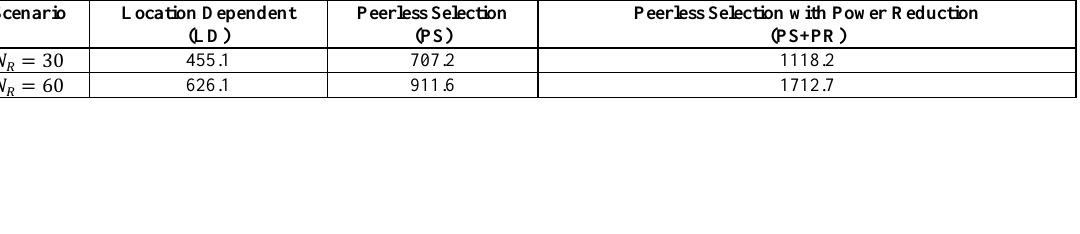
Table 4. Throughput comparison between different schemes during five cycles